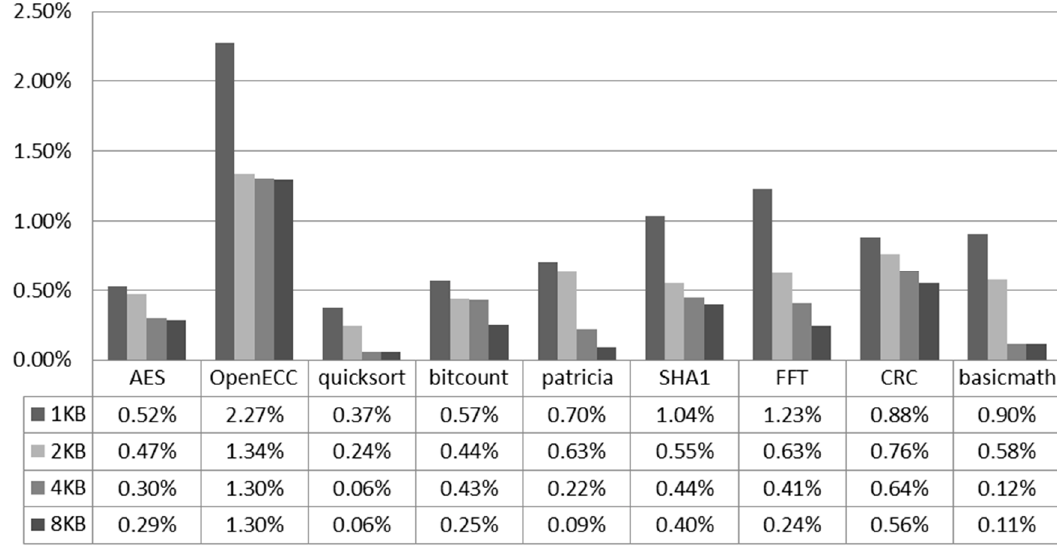
Figure 10. The performance overhead of the selected benchmarks with 1/2/4/8 KB data cache.